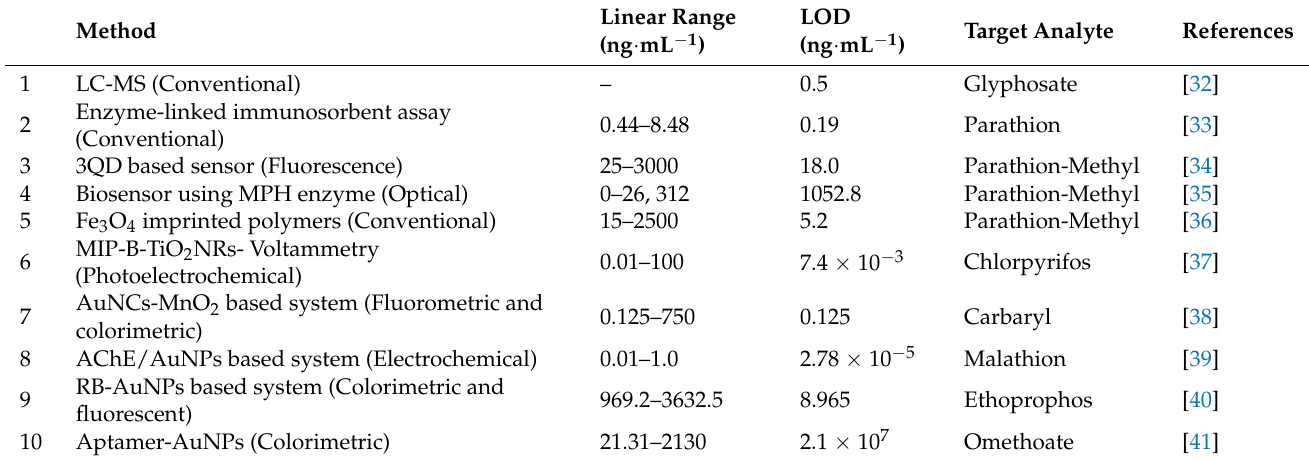
Table 1. Summarizes different methods that are devised for the detection of OP